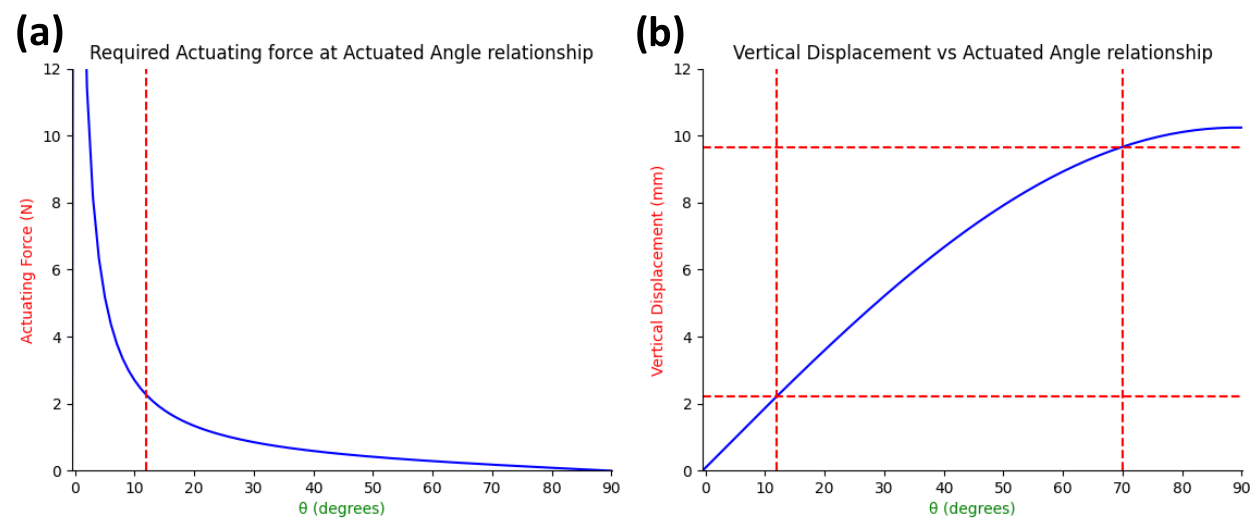
Figure 4. ( a ) The required actuating force to overcome the reactive force of a beam in relation to the angle the actuating force is applied to the beam. For the anchor’s case, an angle of 12.5 degrees (as indicated by the red line) was set to avoid the extreme peak that lower angles experience. ( b ) Theoret- ical vertical displacement the leg achieves when actuated from 0 to 90 degrees. The red lines indicate the chosen bounds of 12.5 to 70 degrees the capsule will actuate between, resulting in approximately 7.5 mm vertical